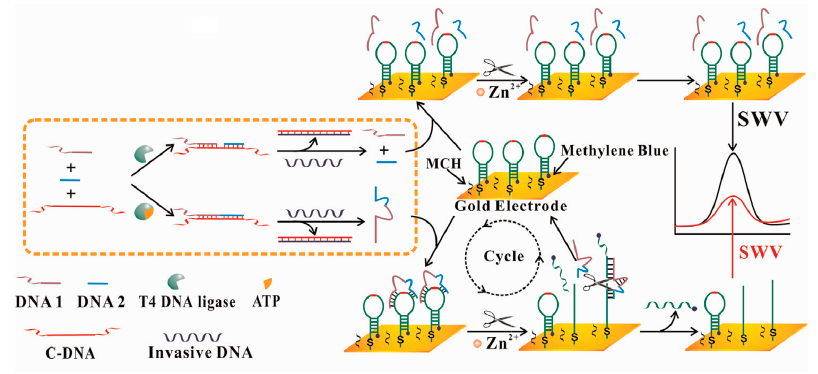
Figure 13. Scheme of the electrochemical sensing system based on the dual strategy of ATP-dependent enzymatic ligation reaction and cyclic amplification based on self-cleaving DNAzyme [89] Copyright 2014. Reproduced with permission from Elsevier B.V.